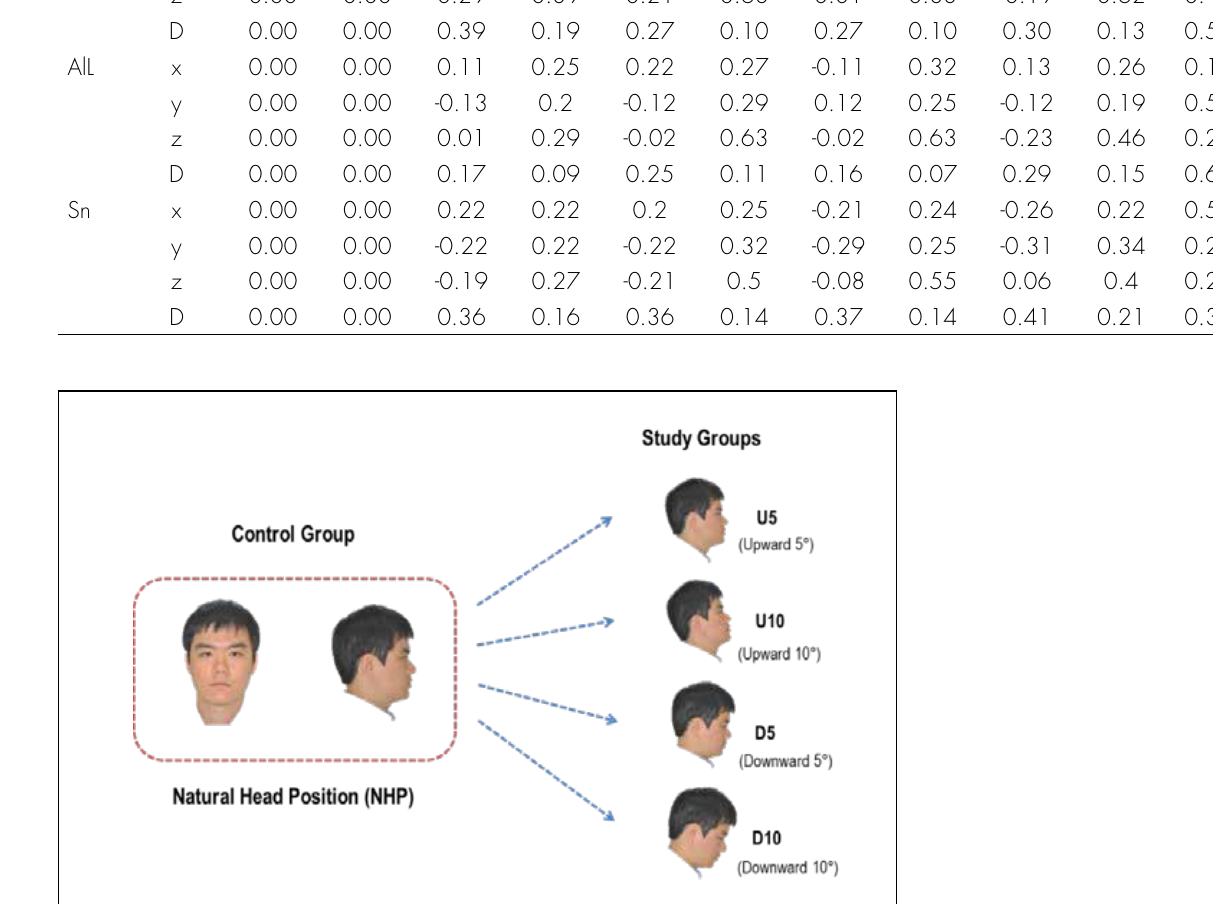
Figure 4. Facial scans performed at five different head postures.